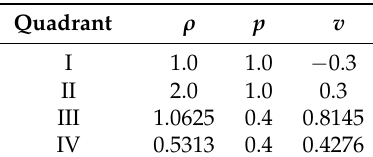
Table 1. Initial condition for 2D Riemann problem—Case 13 by Lax and Liu [27].